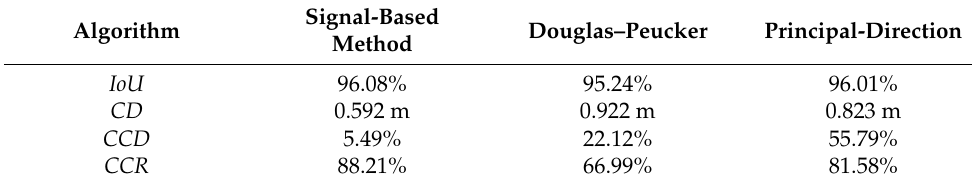
Table 4. Quantitative Analyses